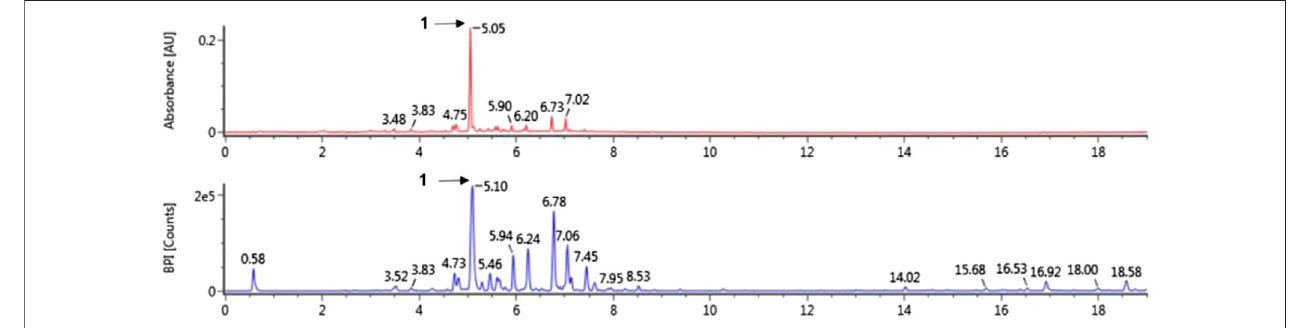
FIGURE 1 | The UV (280 nm) and base peak intensity (BPI) chromatogram of Alnus hirsuta (Spach) Rupr. branch in negative mode using ultra-performance liquid chromatography-quadrupole-time of fl ight mass spectrometry (UPLC-QToF-MS).